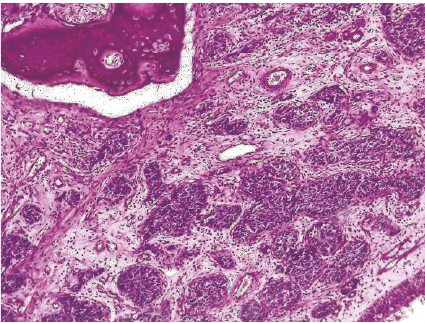
Figure 1: Adamantinoma-like EWS: ill-defined lesion composed of cells arranged in lobules and nests (H and E x 100).